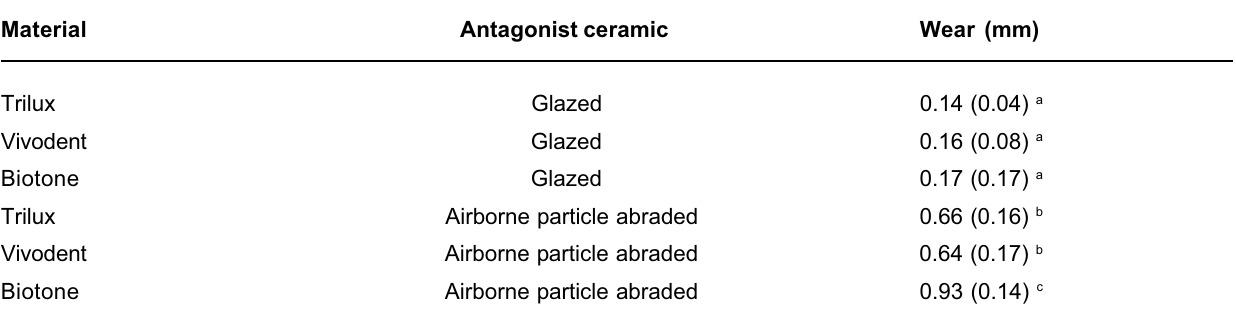
*Data with the same letters are not statistically different within the same antagonist ceramic at 5% significance level. Results are expressed as